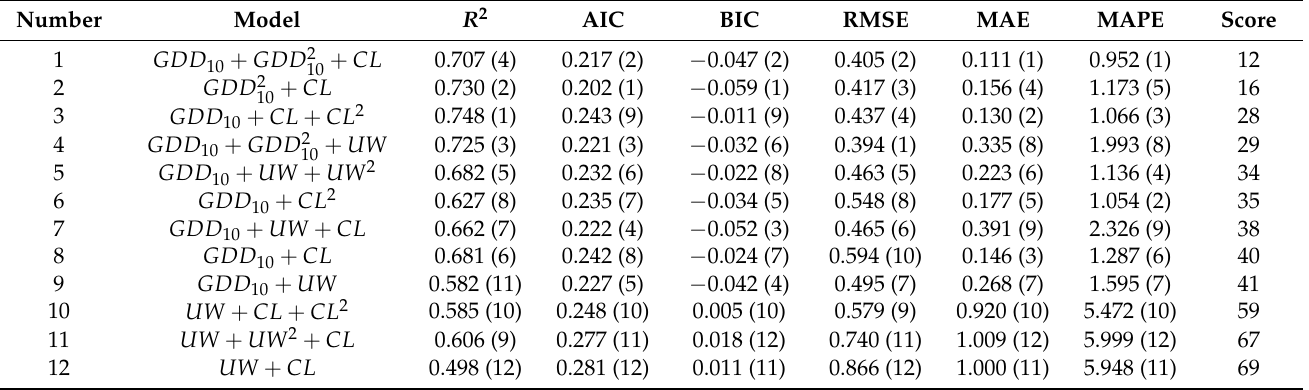
Table 2. Performance of the candidate climotransfer function models. Numbers in parentheses are model rankings per criterion. The sum of the rankings per row is given as a model’s overall score in the right-most column. Lower scores mean higher performances. R 2 , coefficient of determination; AIC, Akaike information criterion; BIC, Bayesian information criterion; RMSE, root mean square error; MAE, mean absolute error; MAPE, mean absolute percentage error.